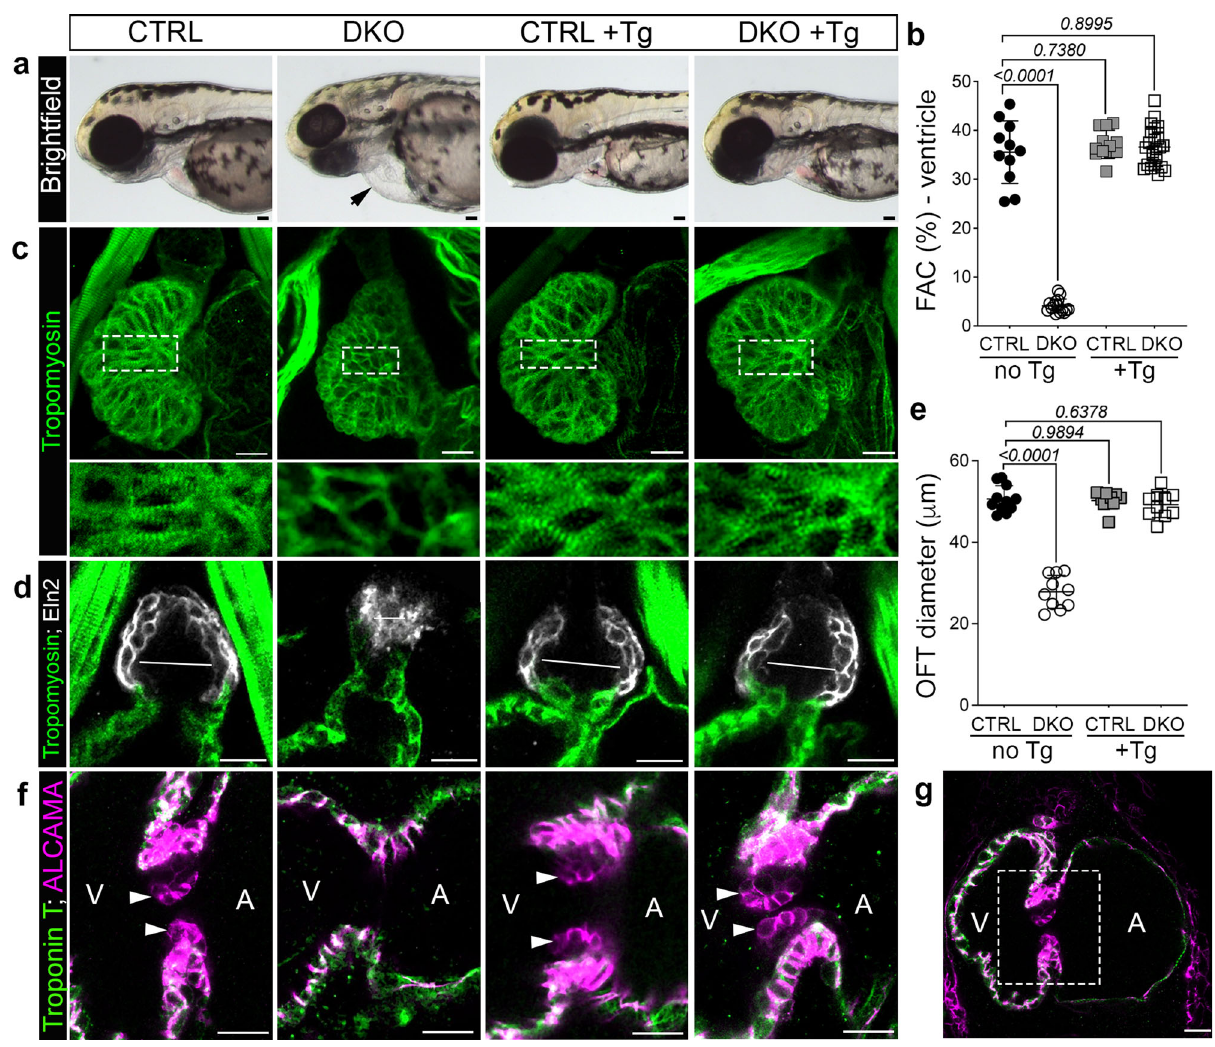
Fig. 6 | Aortic stenosis and valve atresia in rbfox -de fi cient zebra fi sh arise sec- ondary to impaired pump function. a Bright fi eld images of 72hpf CTRL or DKO embryos in the absence or presence of the Tg(myl7:rbfox1l) transgene (Tg). Black arrow highlights pericardial edema in DKO. b Dot plot showing % fractional area change (FAC) of ventricles in 72hpf CTRL or DKO embryos in the absence or presence of the Tg(myl7:rbfox1l ) transgene. c Confocal projections of hearts in 72hpf CTRL or DKO embryos in the absence or presence of the Tg(myl7:rbfox1l ) transgene following immunostaining for Tropomyosin. Boxed regions are shown below each panel at higher magni fi cation. d Confocal sections of out fl ow tracts (OFTs) in 72hpf CTRL or DKO embryos in the absence or presence of the Tg(myl7:rbfox1l )transgenefollowingimmunostainingforTropomyosin(green)and Eln2(white). White lines depictOFTdiameter. e Dotplot showing quanti fi cation of